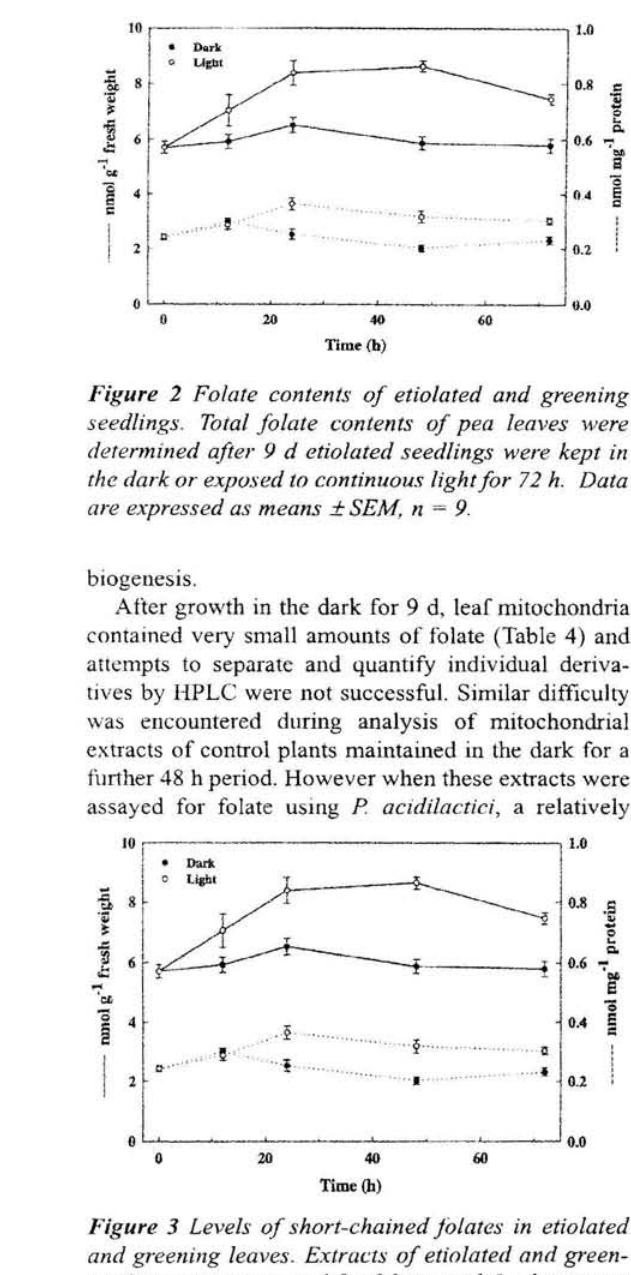
Figure 4 Distribution of individual folates in whole- leaf extracts. Extracts of etiolated and greening leaves were subjected to HPLC and the column ejfluent was assay for folate using L. rhamnosus. Data are expres- sed as means ± SEM, n =